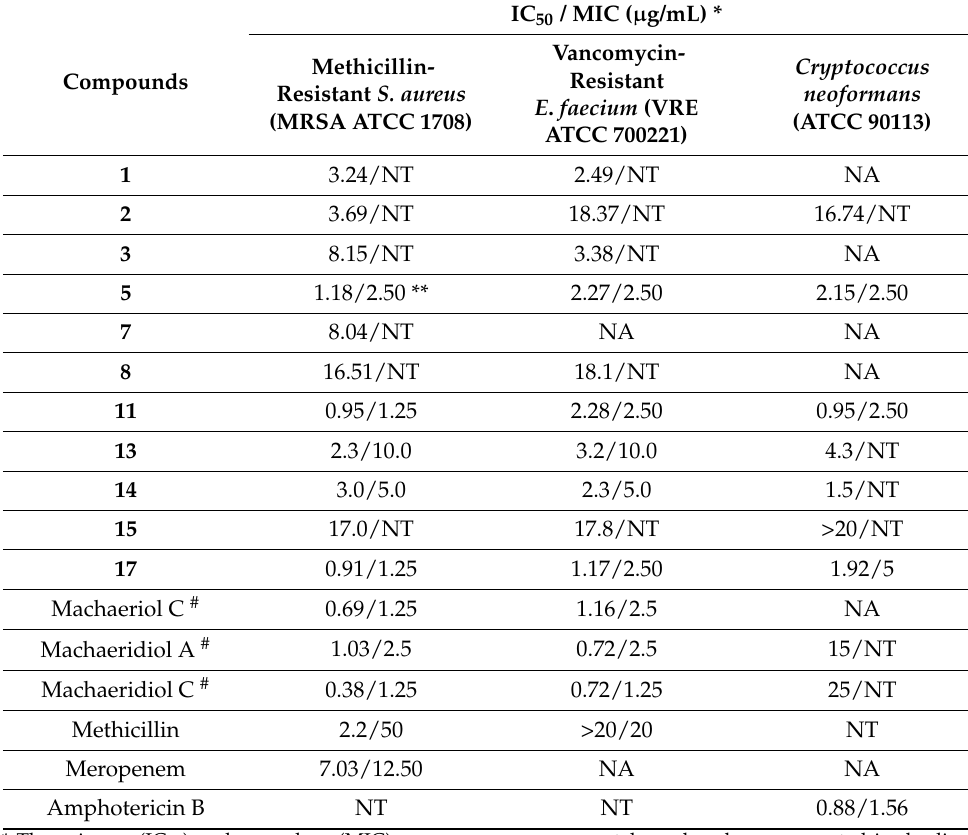
Table 1. Antimicrobial activities* of machaeridiol based synthetic analogs 1 – 3 , 5 , 7 – 11 , 13 – 15 , and 17